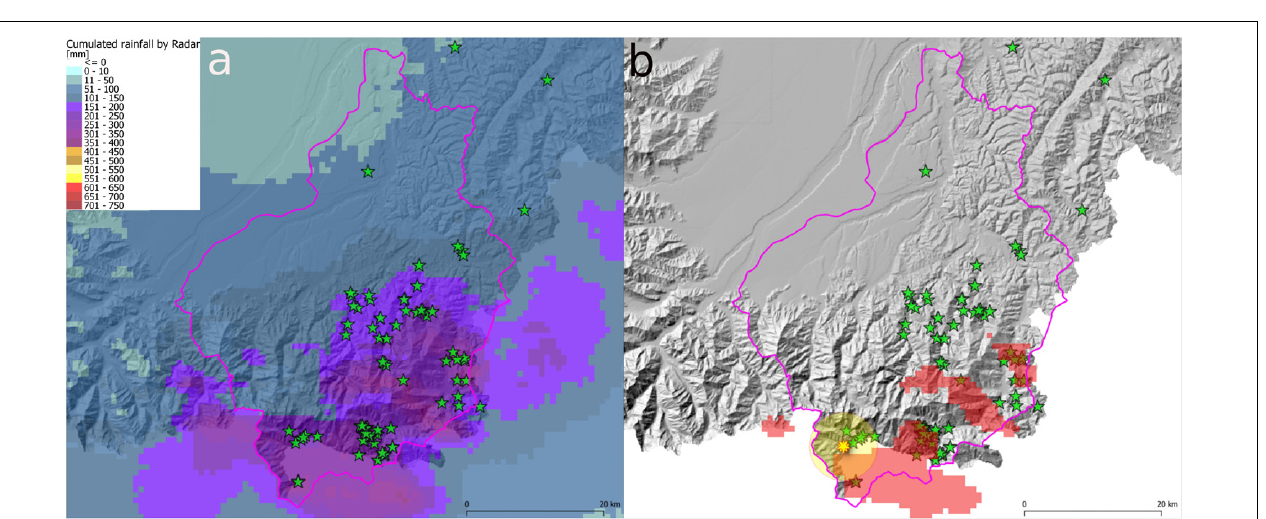
FIGURE 5 | (a) Accumulated rainfall from 23rd November at 21:00 UTC in Alto Tanaro. (b) In red, areas interested by precipitations that overpassed thresholds of Equation 3 (critical rainfall accumulations) and rain gages overpassing threshold (yellow asterisks) and related buffers (yellow circles); green star labels indicate occurred landslides.